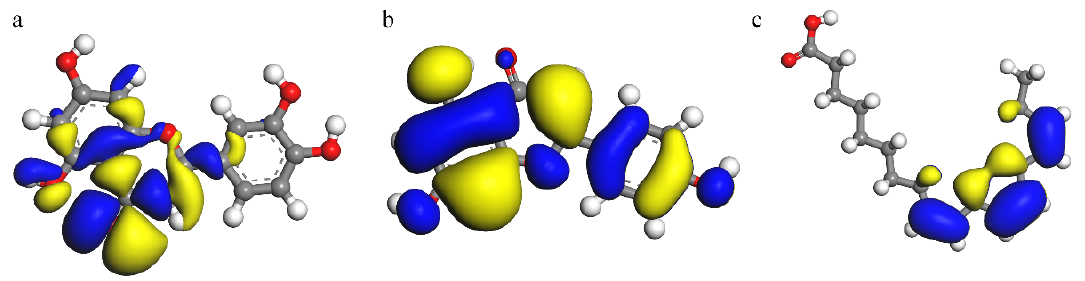
Figure 9. The optimized geometric configurations: ( a ) luteolin, ( b ) apigenin and ( c ) α -linolenic acid.